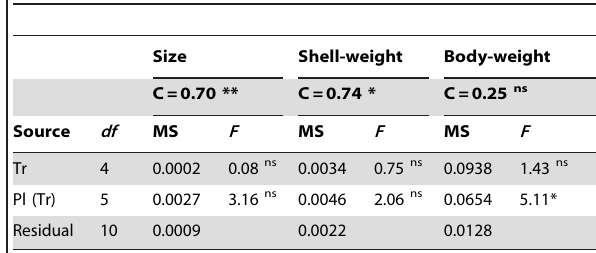
Table 3. Analyses of changes in size, shell-weight and body- weight of large